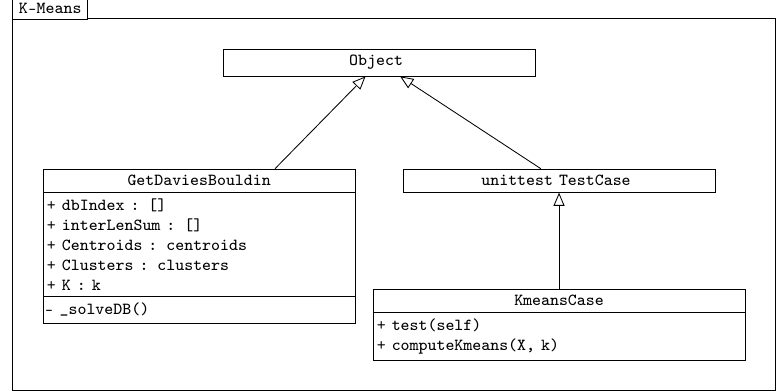
Figure 2. Partial K-Means.py class